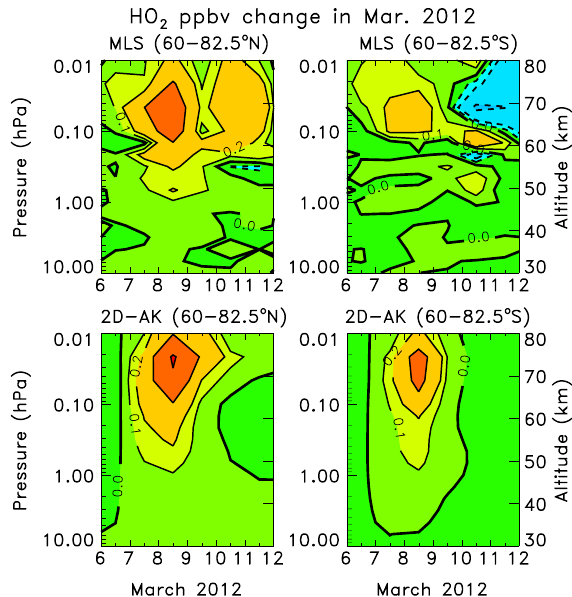
Fig. 4. Daily averaged HO 2 changes from Aura MLS measurements ( Top ) and GSFC 2-D model predictions ( Bottom ) for the 60–82.5 ◦ N band ( left plots ) and 60–82.5 ◦ S band ( right plots ). An average ob- served (predicted) HO 2 profile for the period 2–6 March 2012 was subtracted from the observed (predicted) HO 2 values for the plotted days of 6–11 March 2012. The contour intervals for the HO 2 differ- ences are − 0.5, − 0.2, − 0.1, 0.0, 0.1, 0.2, 0.5, and 1ppbv. The MLS averaging kernel (AK) was used to sample the model results.